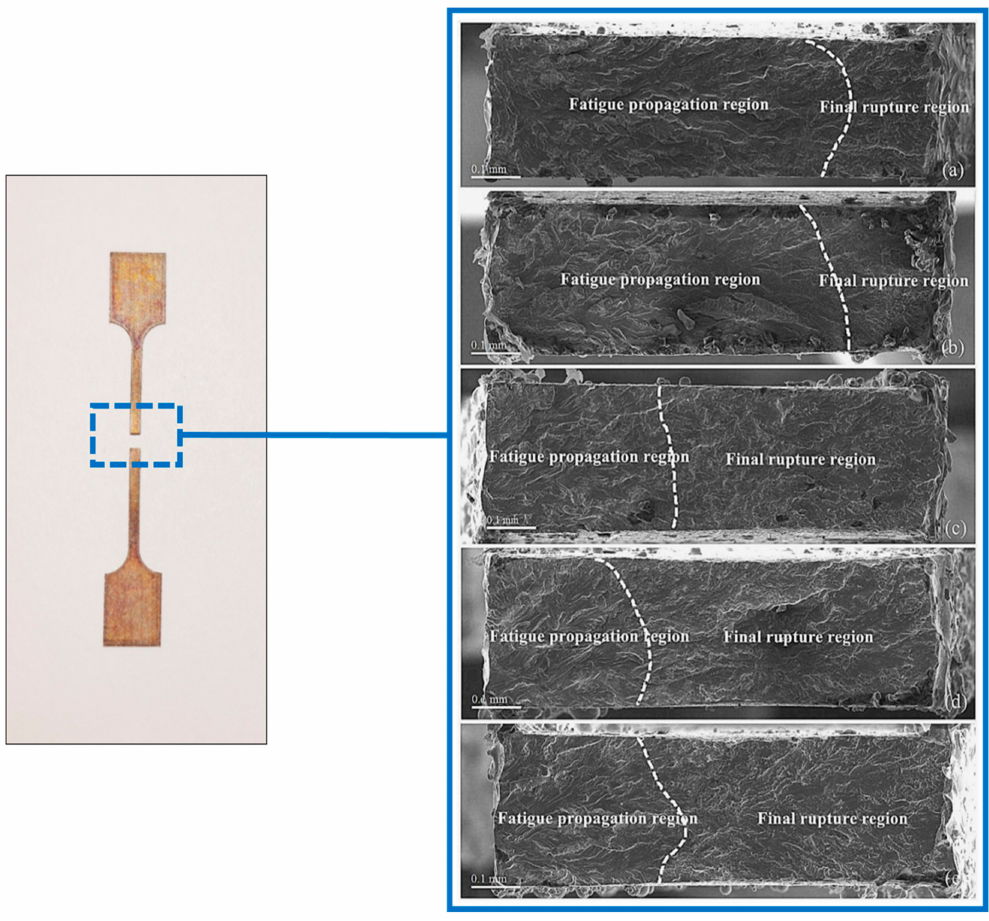
Figure 11. SEM micrograph of fracture of di ff erent strain amplitude: ( a ) 0.6%, ( b ) 0.8%, ( c ) 1.2%, ( d ) 1.6%, and ( e )